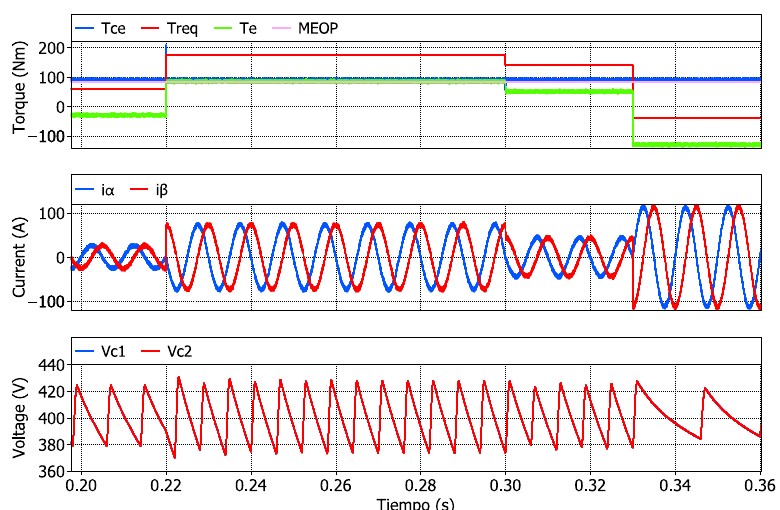
Figure 14. Dynamic operation of Torques at the drive train, α − β currents, and dc-voltages.